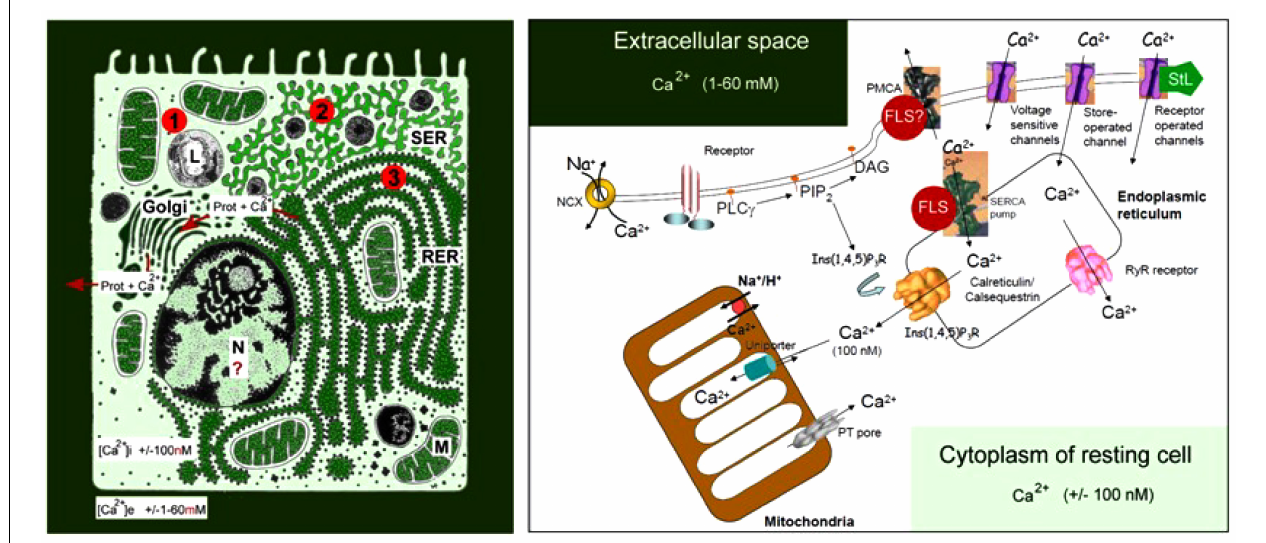
FIGURE 1 | Schematic representation of the main Ca 2 + gradients in eukaryotic animal cells (Left panel) and of the main players in Ca 2 + -homeostasis (Right panel). Left: schematic representation of the Ca 2 + gradient (adapted from De Loof, 2015, 2017). The different shades of green are not meant to give an exact representation of differences in Ca 2 + -concentration. L, lysosome; N, nucleus; M, mitochondrion; RER, rough endoplasmic reticulum; SER, smooth endoplasmic reticulum. The red dots with 1, 2, and 3 correspond to the main mechanisms for keeping [Ca 2 + ]i low. (1) Little influx of Ca 2 + through the plasma membrane that can be countered by the activity of Ca 2 + -ATPases in the plasma membrane (PMCAs); (2) more influx and role for temporary storage of Ca 2 + in membrane-limited organelles, in particular the SER; (3) high influx of Ca 2 + triggers the removal of excess Ca 2 + through the secretion of Ca 2 + -binding/transporting proteins via the RER. From De Loof (2017). Right: the major events in the Ca 2 + -homeostasis system (slightly modified after Orrenius et al., 2003). The long legend as originally formulated by Orrenius et al. (2003) is not repeated here De Loof